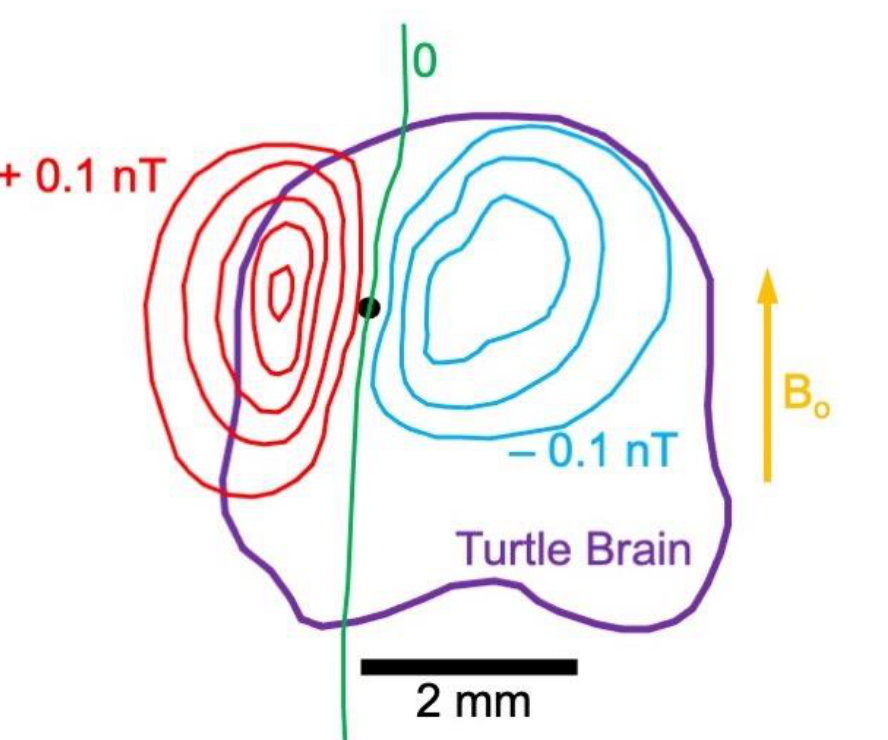
Figure 11. The magnetic field produced by a turtle cerebellum. The component of the biomagnetic field parallel to the static magnetic field of the MRI scanner (B o , yellow) is shown in a contour plot. Each contour corresponds to an increment of 0.1 nT; red contours mean the biomagnetic field is parallel to B o (positive) and blue contours mean it is opposite to B o (negative); the zero contour is green. The black dot indicates the approximate position of a current dipole directed into the paper. Adapted from Figure 10A in [72].